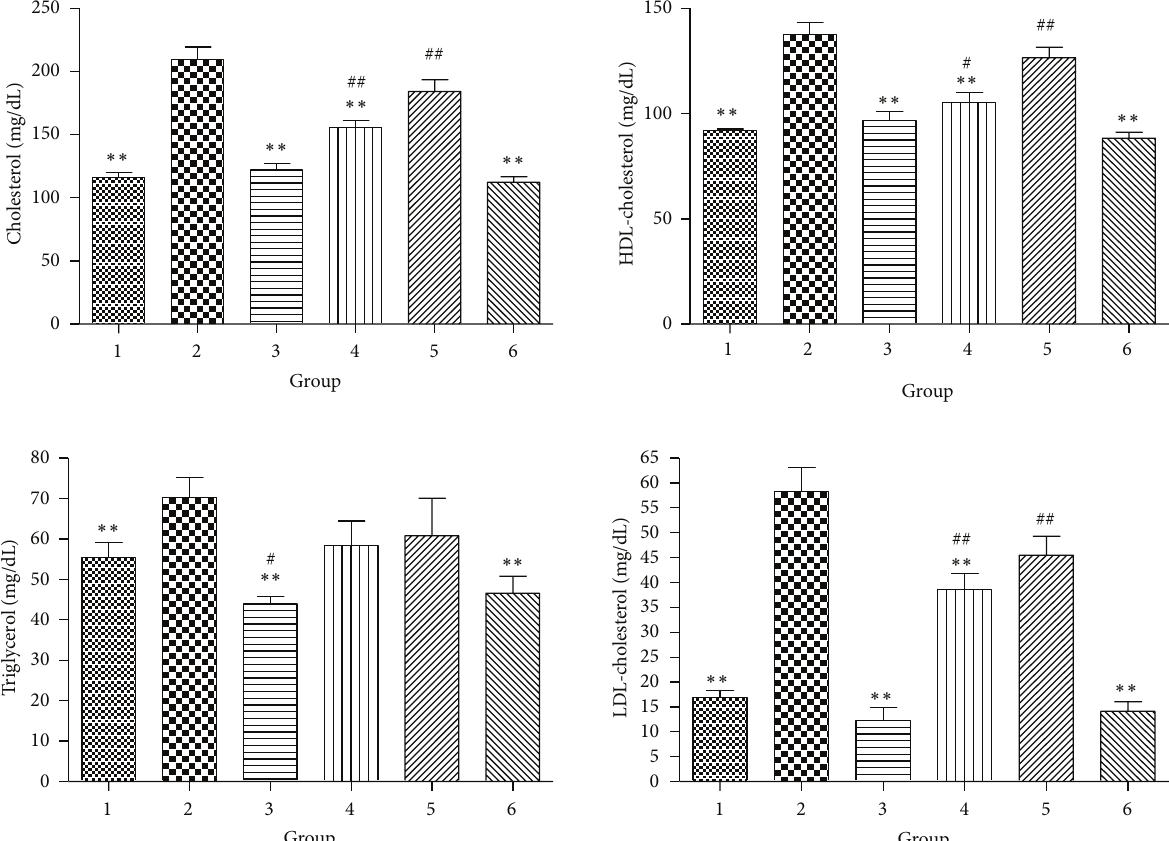
Figure 4: Levels of serum lipids ( ∗ 𝑃 < 0.05 compared with Group 2. ∗∗ 𝑃 < 0.01 compared with Group 2; # 𝑃 < 0.05 compared with Group 1. ## 𝑃 < 0.01 compared with Group